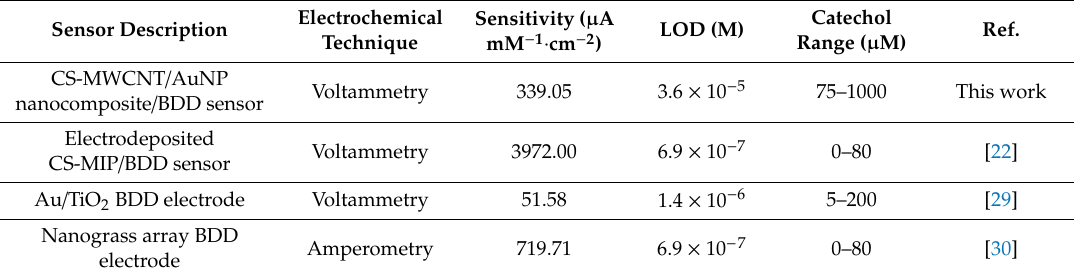
Table 1. Analytical performance of enzyme-free sensors for catechol detection